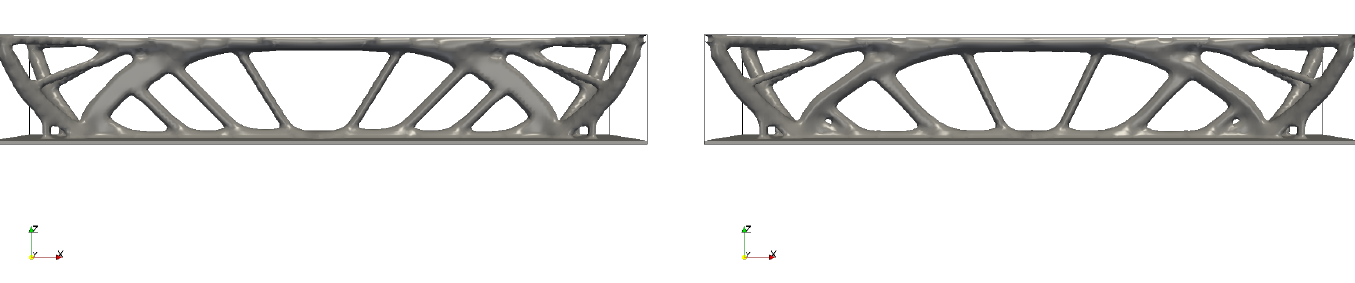
Fig. 10 Optimized designs for the three-dimensional bridge example of Section 5.5, (left) without manufacturing constraints, (right) solving Problem (30) with α c = 0 . 7